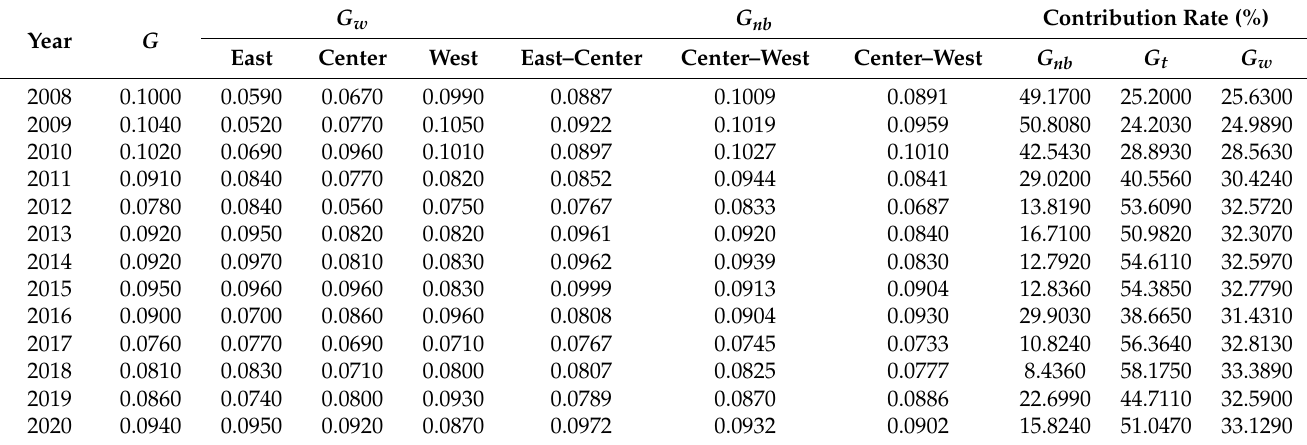
Data source: calculated according to Formulas (8) and (9) based on the data in Table